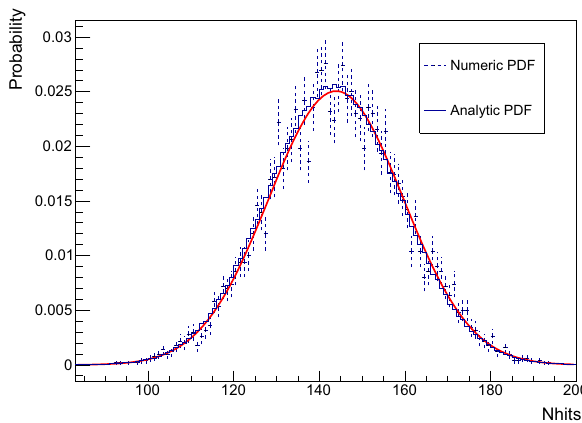
Fig. 1 Comparison of NHit distribution for 1 MeV electrons isotrop- ically distributed in a 50 kT detector simulated fully with Geant4 (numeric PDF) and with only Cherenkov light simulated and scintil- lation light contribution determined from pregenerated tables (analytic PDF)